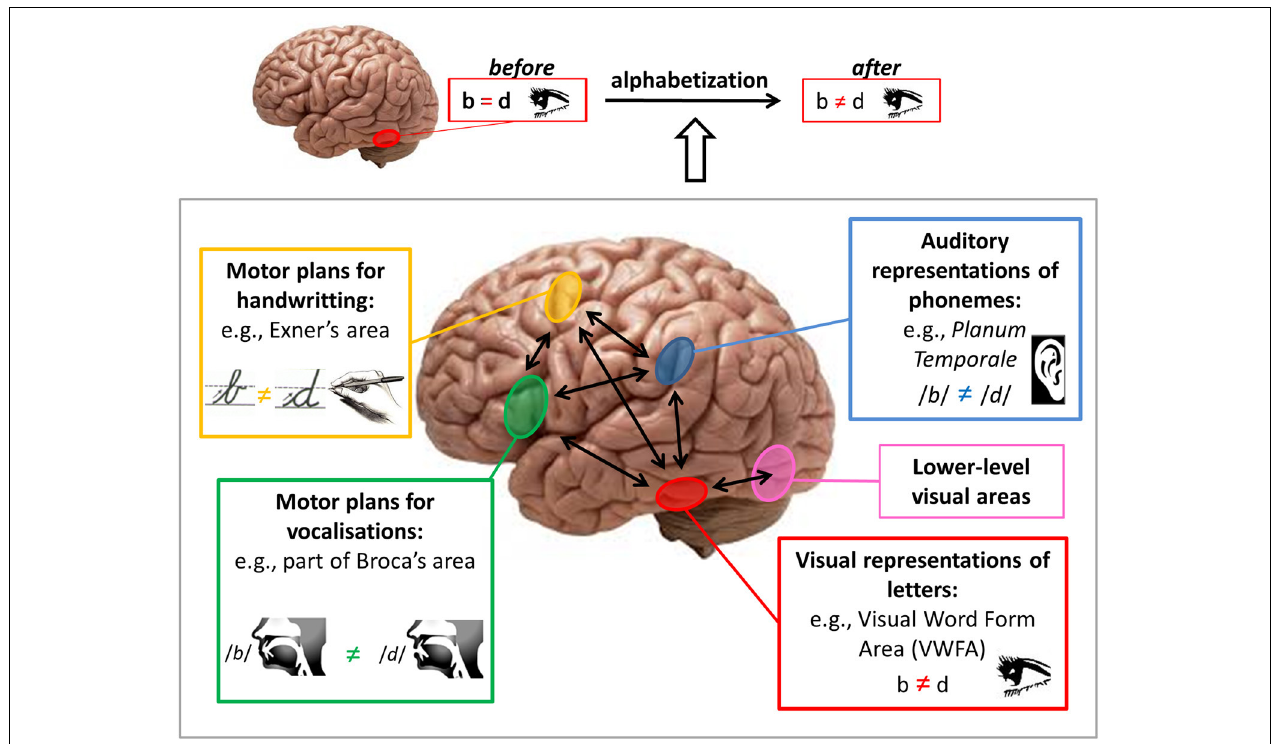
FIGURE 1 | Brain pathways for mirror discrimination learning during literacy acquisition. Upper: The Visual Word Form Area [VWFA] (in red) presents mirror invariance before alphabetization and mirror discrimination for letters after alphabetization. Lower: During alphabetization, the VWFA can receive top-down inputs with